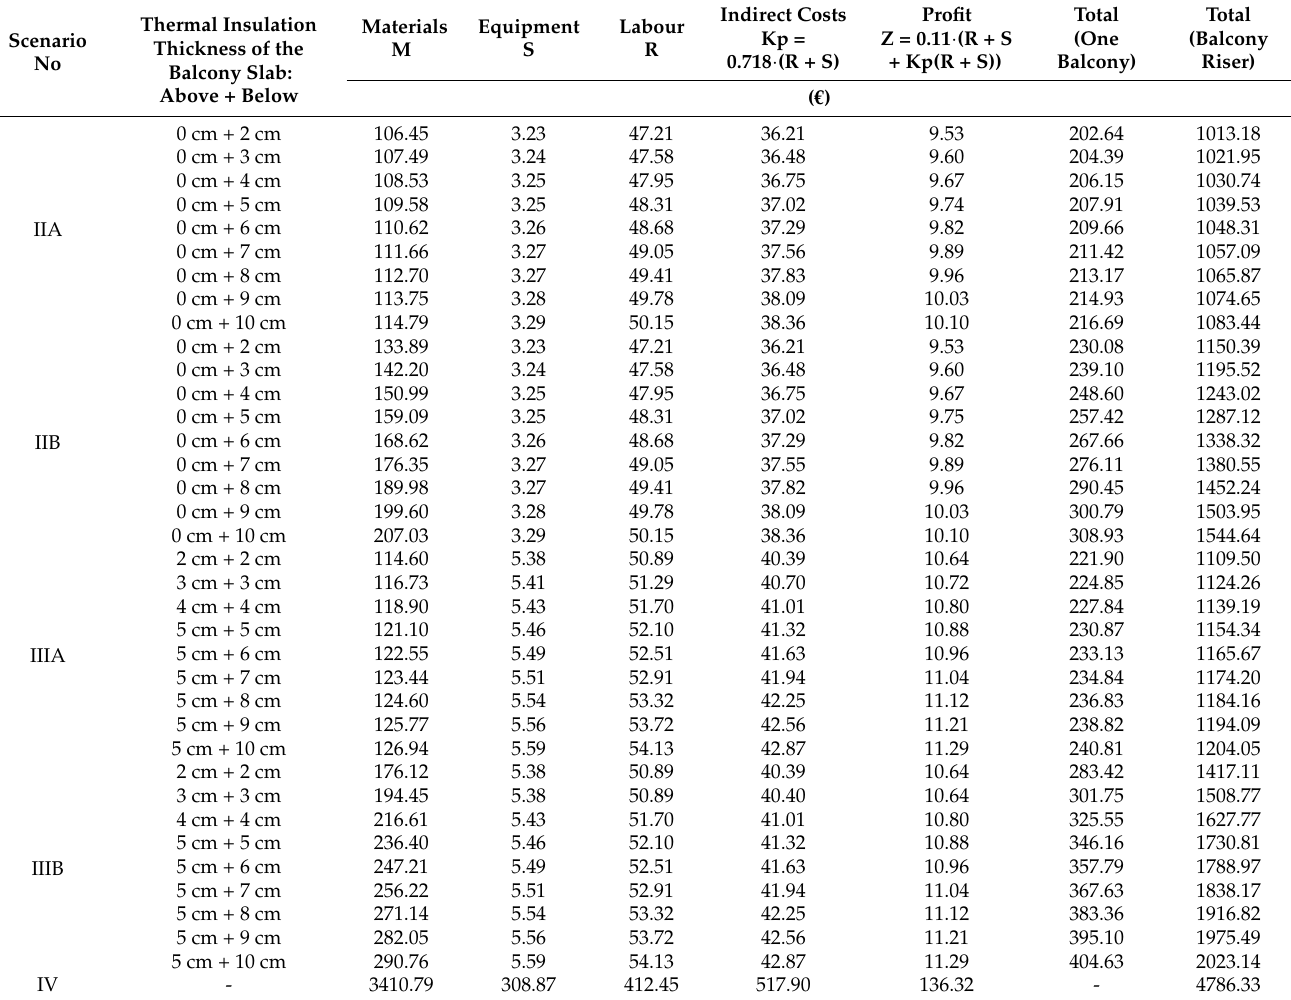
Table 5. Inputs needed to carry out the investment for individual